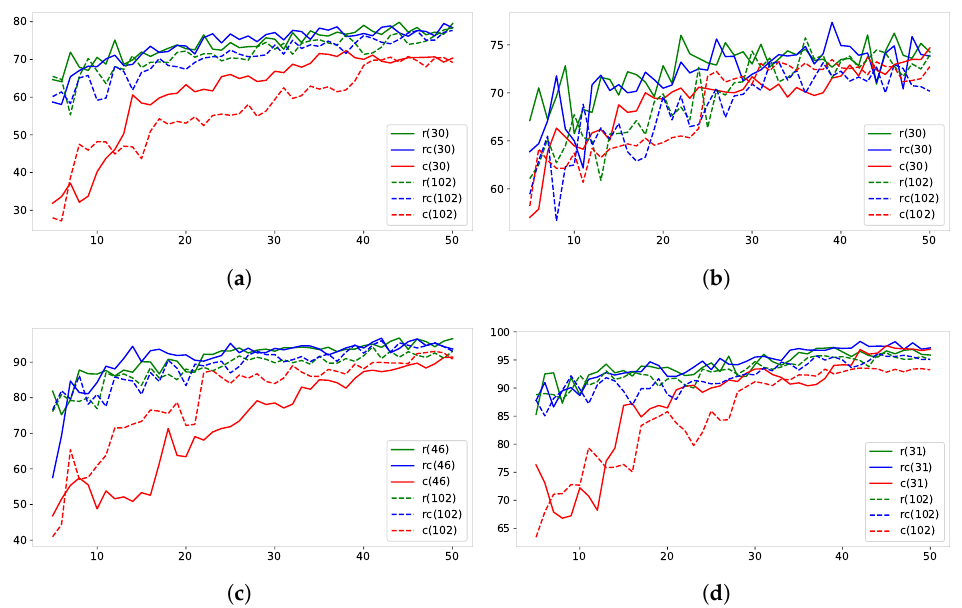
Figure 4. Comparison of accuracy results (in percentage 100%) according to the types of features and the sampling strategies: the graphs show results when the best features are used (continuous lines) and when all 102 features are used (dashed lines). This comparison is made considering the types of samples r , rc , and c , with 10 samples per cluster for data sets DS1 ( a ), DS2 ( b ), DS3 ( c ), and DS4 ( d ). In the graphs, the x -axis corresponds to the cluster values and the y -axis corresponds to the accuracy